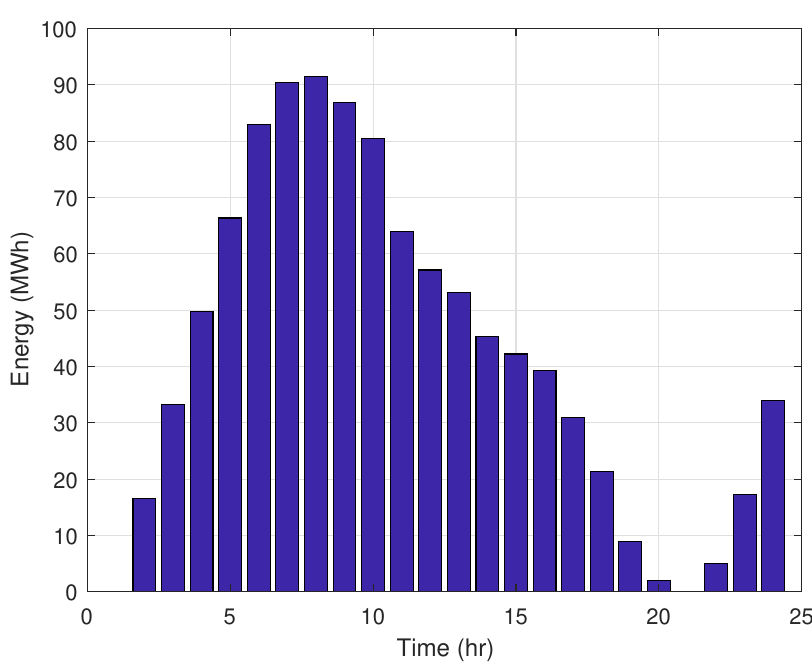
Figure 15. Stored energy in